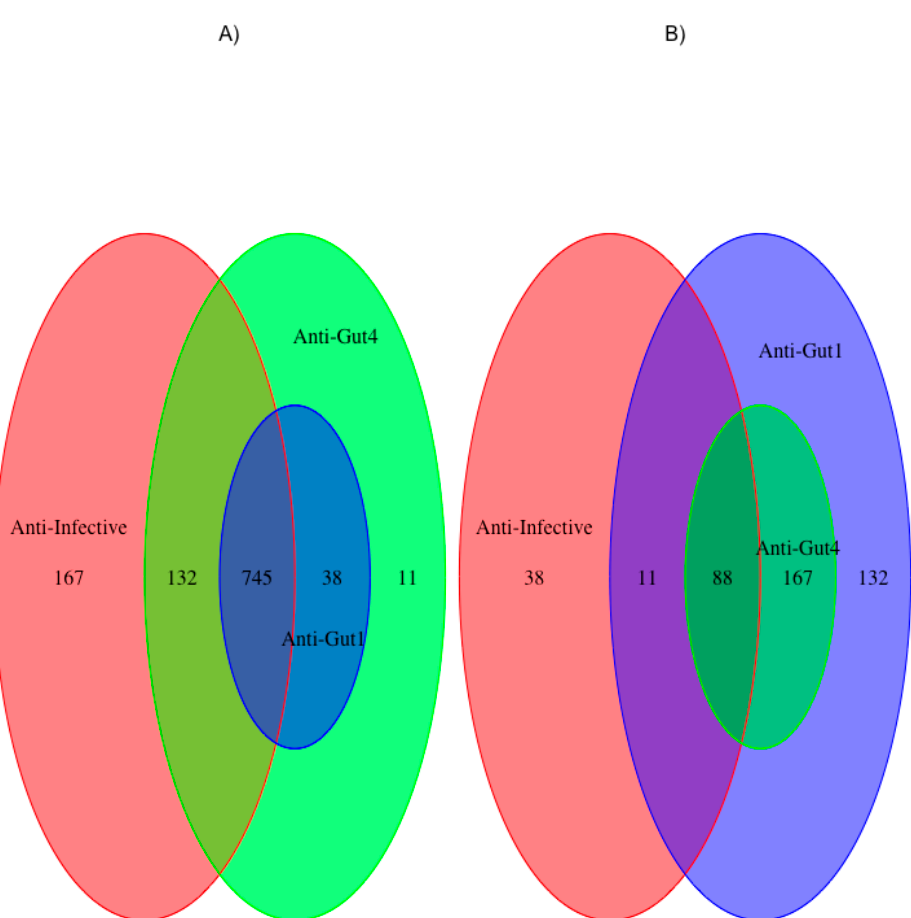
Figure 1. Datasets. The three datasets used throughout this work, including 1181 FDA-approved drugs. Anti-infective set (red ovals) includes 137 compounds that had been classified by the ATC as anti-infective, anti-gut1 set (blue ovals) includes 398 compounds with antimicrobial activity against 1 or more gut bacterial strains, anti-gut4 set (green ovals) includes 255 compounds with antimicrobial activity against four or more gut bacterial strains; the actual compound names and chemical formulas are reported in Supplementary Files S1–S3, respectively. These 3 sets are derived from the same set of compounds hence share some overlaps that are presented in Venn diagrams for ( A ) non-antimicrobials and ( B ) antimicrobials.